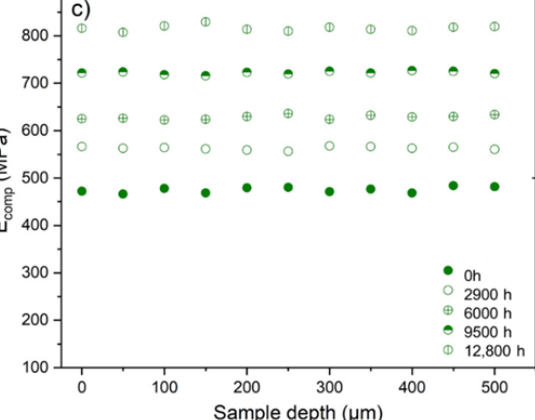
Figure 13. Changes in the profiles of elastic modulus in the film thickness for the unfilled Si-XLPE matrix ( a ) and the two composite materials with 25 phr ( b ) and 50 phr ( c ) of ATH, during their radio-thermal exposure in air under 8.5 Gy · h − 1 at 47 ◦ C.